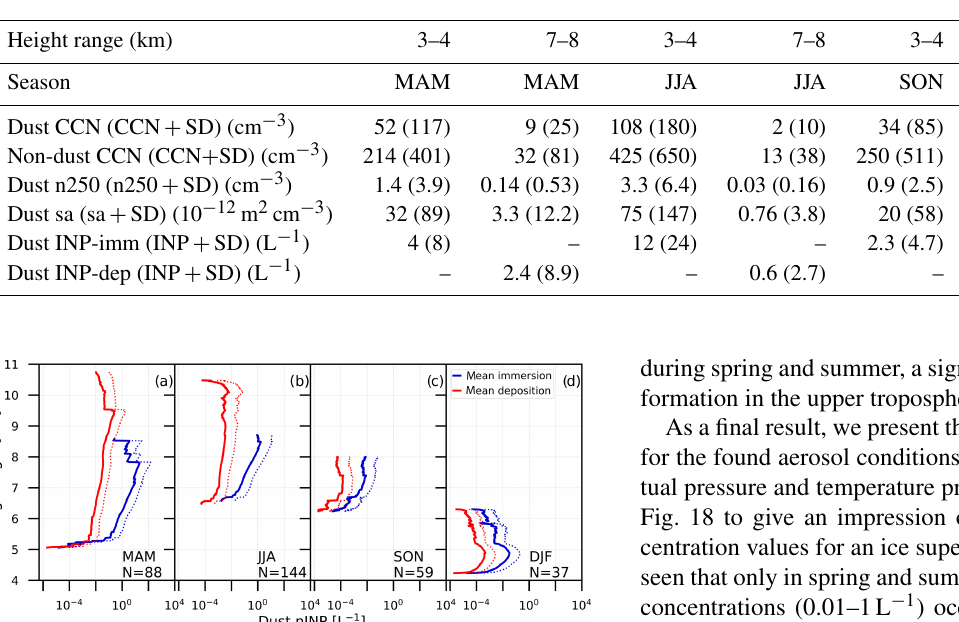
Figure 18. Same as Fig. 17 except considering actual temperature and pressure